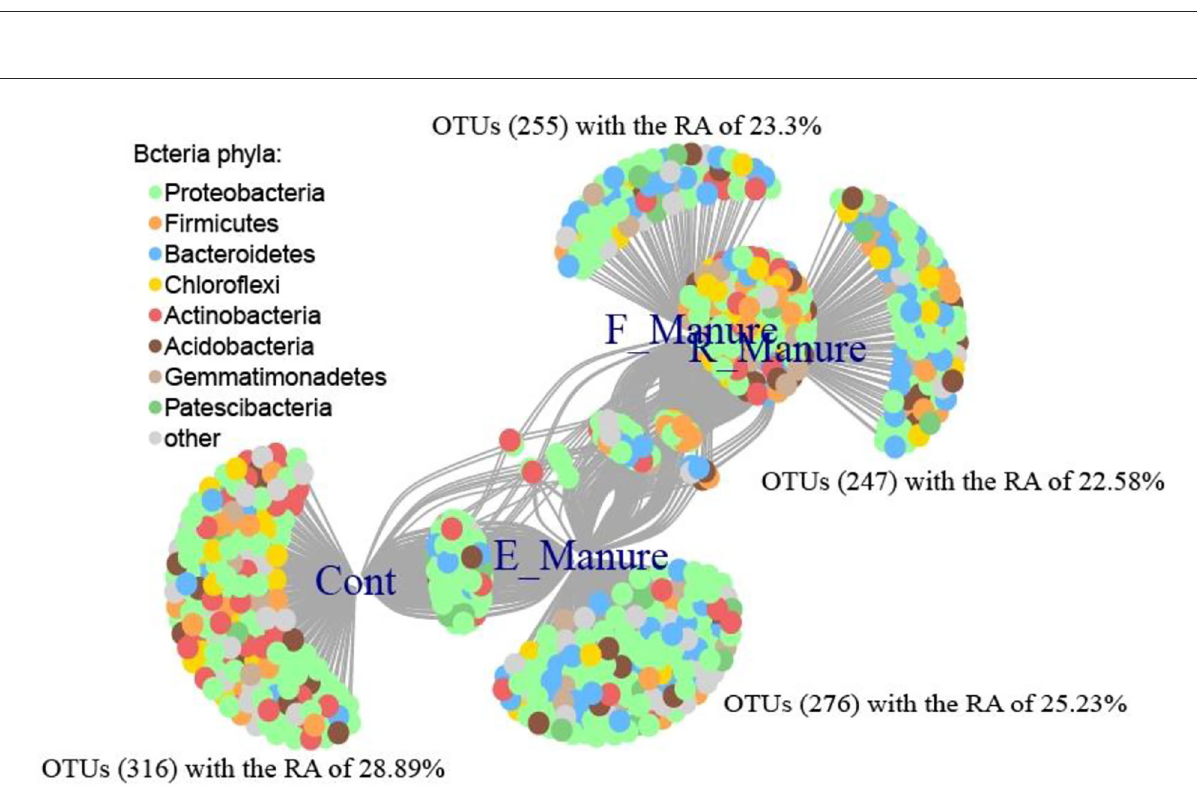
FIGURE4 Taxonomic distribution of the bacterial communities in the four treatments of fertilization. The phyla with an abundance of < 1% are indicated as “others.” For Proteobacteria, the classes are not indicated. The stacked column bar graph was generated using R software.